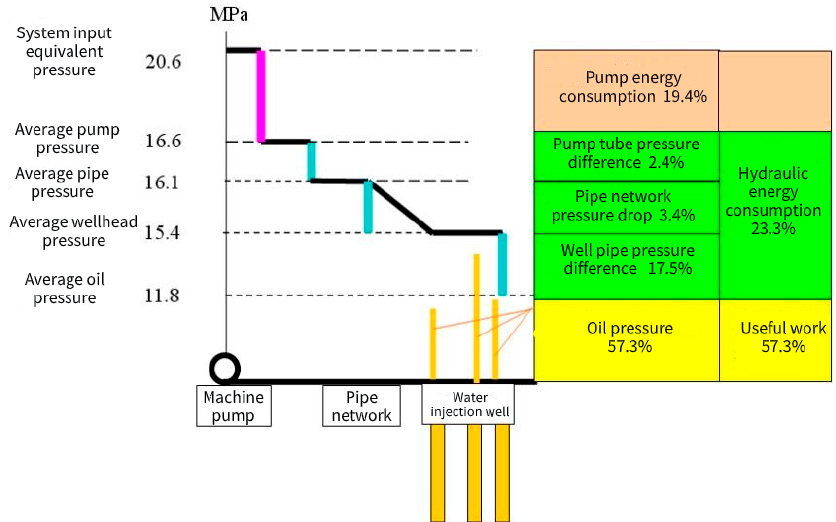
Figure 8. Analysis of pressure and energy consumption in the X plant.